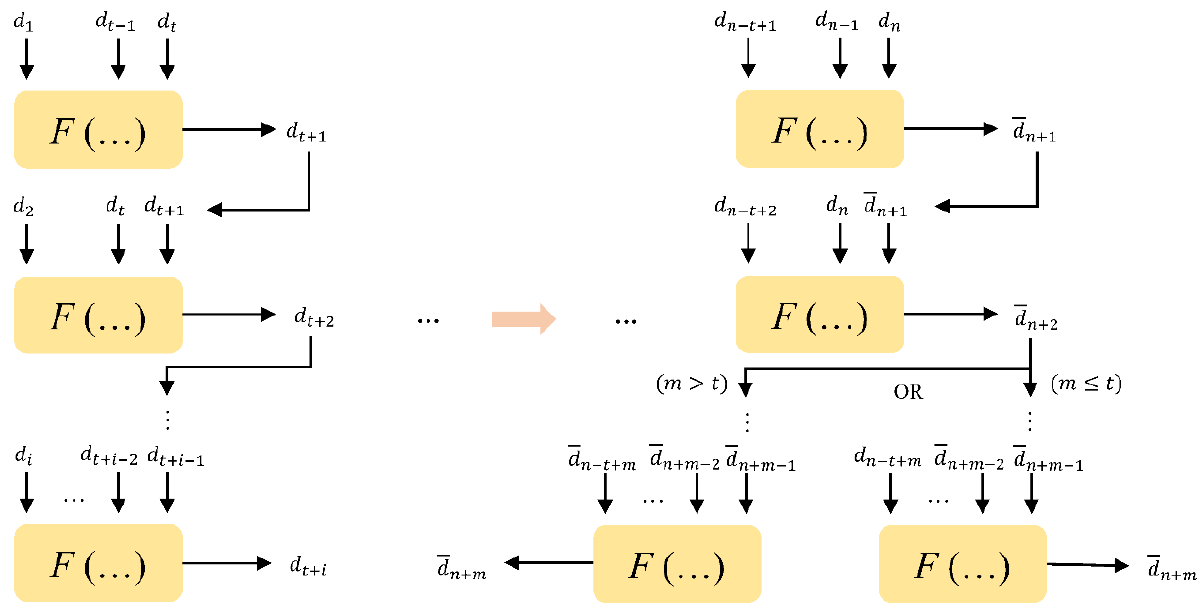
Figure 1. Intelligent analysis of tunnel surrounding rock deformation.